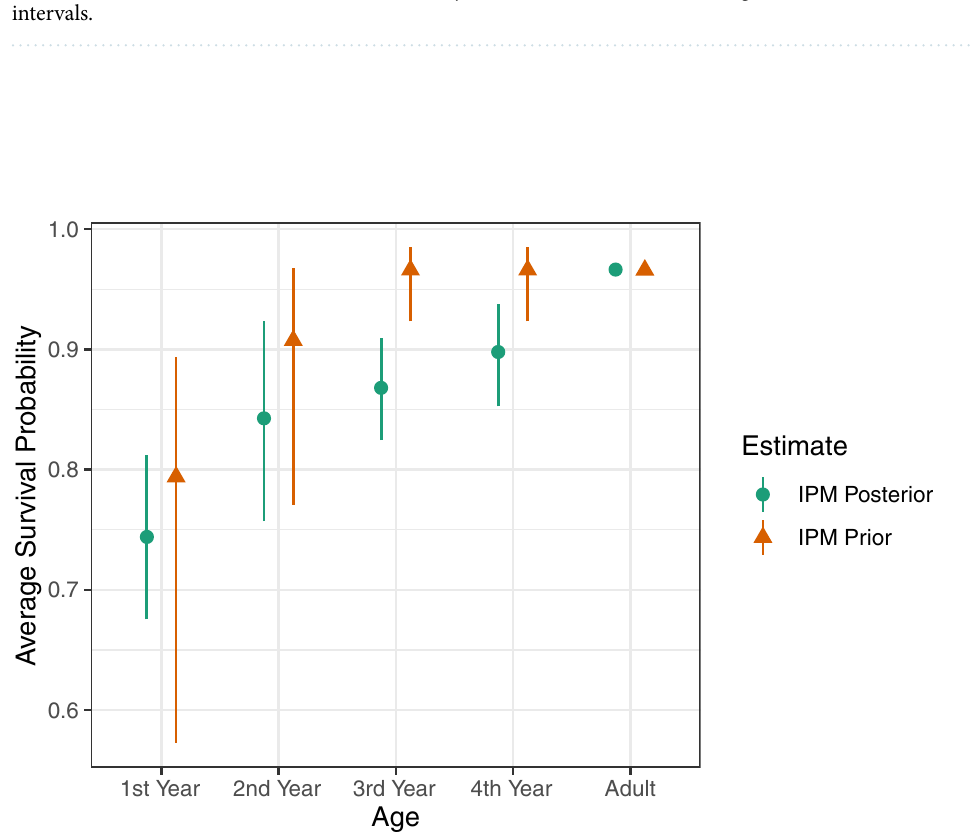
Figure 8. Estimated survival probabilities (averaged across years) by age class. The estimated IPM prior is from the photo-identification analysis of adult manatees in southwest Florida and mortality ratios from a photo- identification analysis of manatees in the Upper St. Johns River 26 . The estimated IPM posterior integrates those estimates with carcass recoveries and other data. Symbols indicate medians; line segments indicate 95% credible